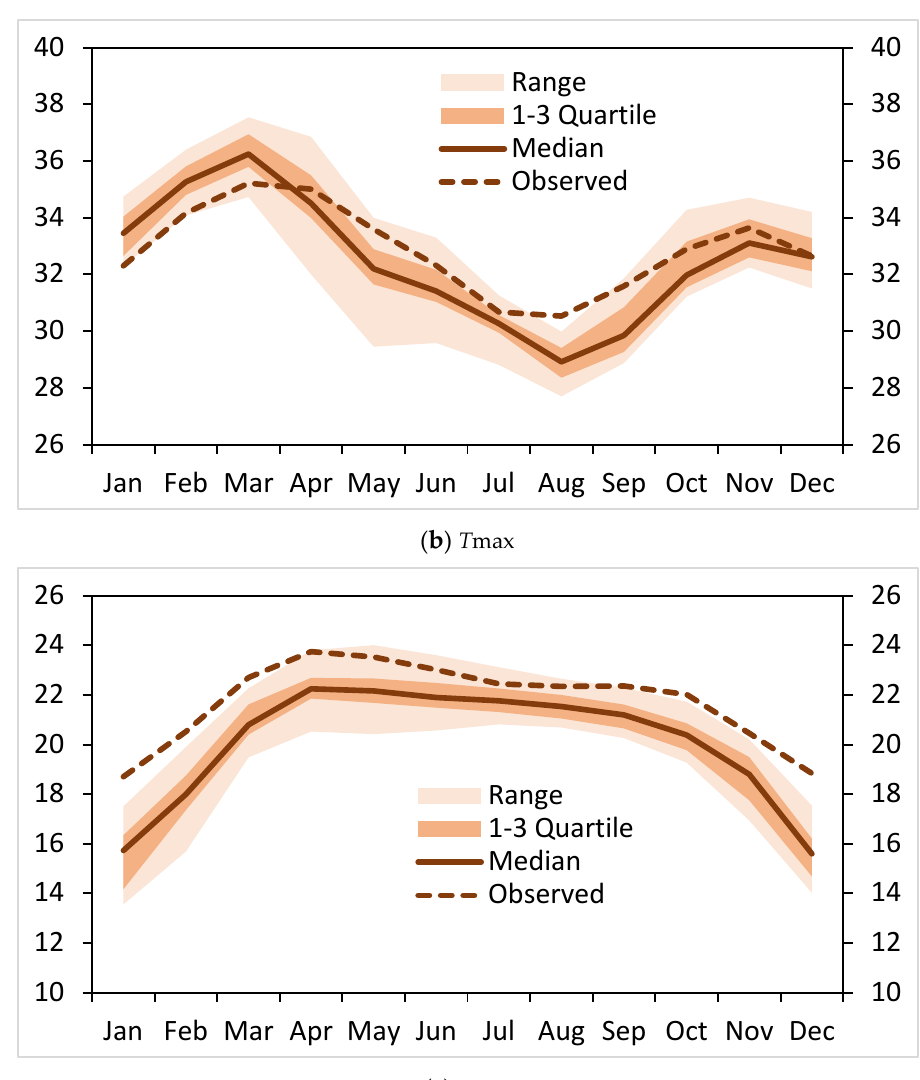
Figure 4. The annual seasonal cycle of observed and modelled of ( a ) Precipitation (PRCP) in mm/month; ( b ) Maximum Temperature ( T max) in ◦ C; and ( c ) Minimum Temperature ( T min) in ◦ C over Nigeria between 1981 and 2005. Note: The light pink color indicates the range between the maximum and minimum values; the dark pink shows the range between the 25th and 75th percentiles, while the thick line indicates the models’ median and the dashed line shows the NIMET